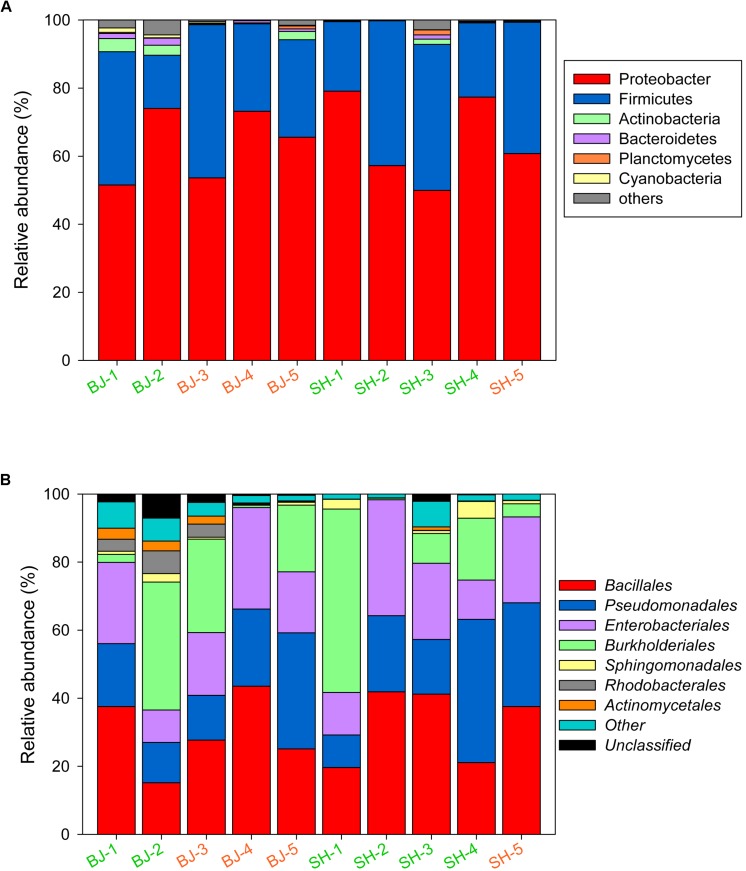
Bacterial community structure for PM2.5 samples at the phylum (A) and order level (B). Taxonomic summary of the most abundant phylum (>1%) and order (>2%) was indicated in the figure.